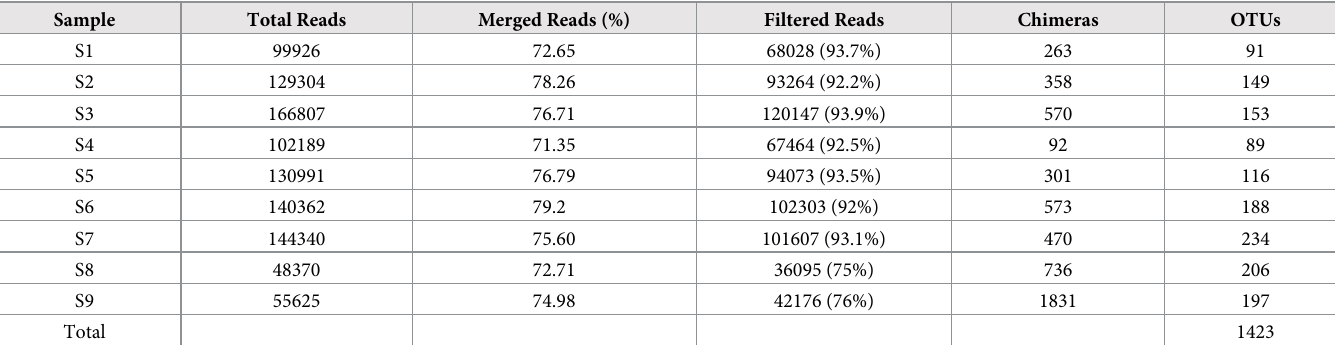
Table 2. Total number of OTUs resulting from the UPARSE pipeline dataset. Sample